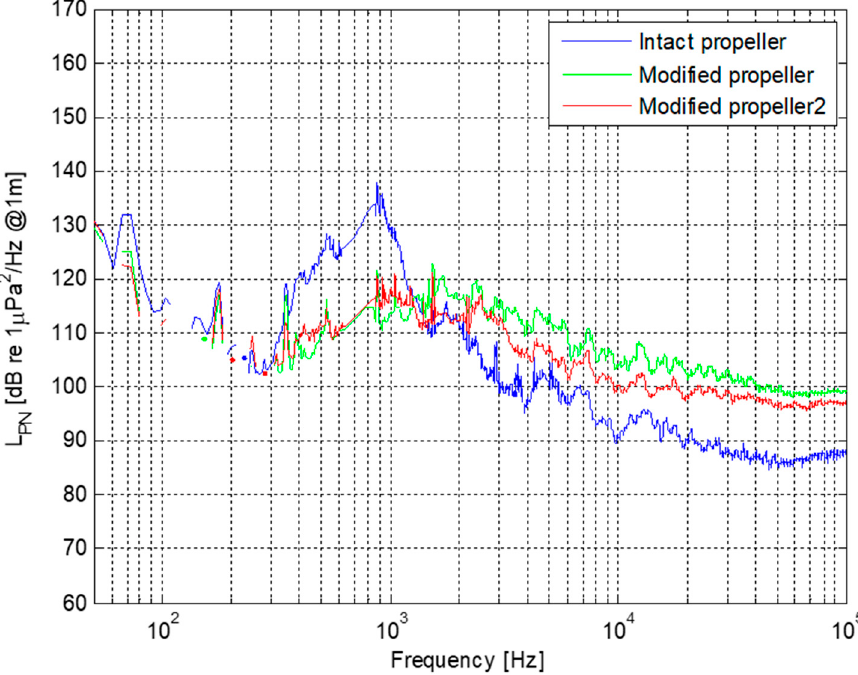
Figure 15. 2 Net noise levels: Intact, Modified propeller and Modified Propeller-2 in the 1 m (narrowband), condition V1, hydrophone H3.